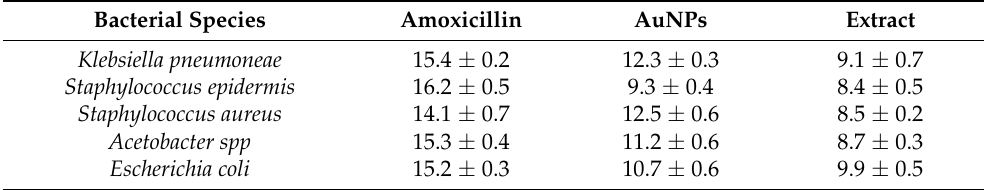
Table 3. Antibacterial zone of inhibition (mm) of extract and its mediated AuNPs. Bacterial Species Amoxicillin AuNPs Extract Klebsiella